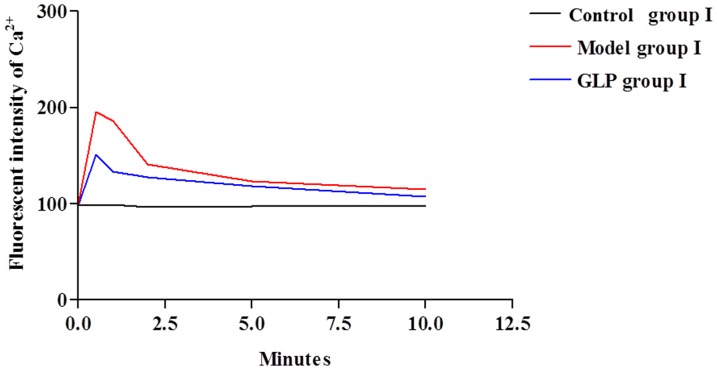
Changes in fluorescence intensity of Ca2+ in neurons during establishment of the model, n  =  4, thirty neurons were observed in each replicate.There is a significant increase (within 30 seconds) in fluorescence intensity of Ca2+ in neurons in the model group compared to the control group (p<0.001). This increase also occurs in the GLP I group, and it decreases in both Model and GLP I groups with time up to 10 minutes when the Model group is still significantly higher than the Control group I, but, there is no difference between the Control group I and GLP I groups at 10 minutes. Tukey’s test following one way ANOVA was used to perform statistical analysis.